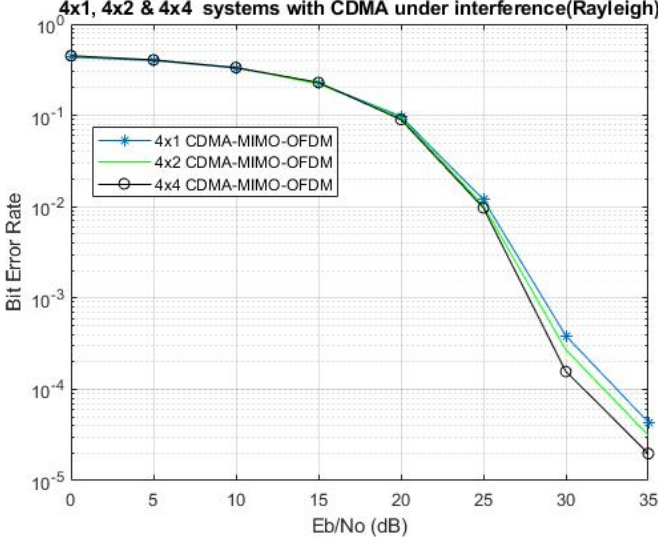
Figure 13. SNR vs. BER plot in Rayleigh channel for CDMA-MIMO-OFDM model.